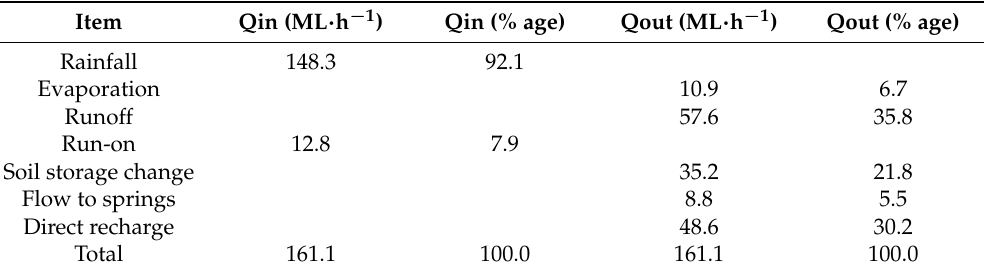
Table 6. Water balance calculated over the simulation